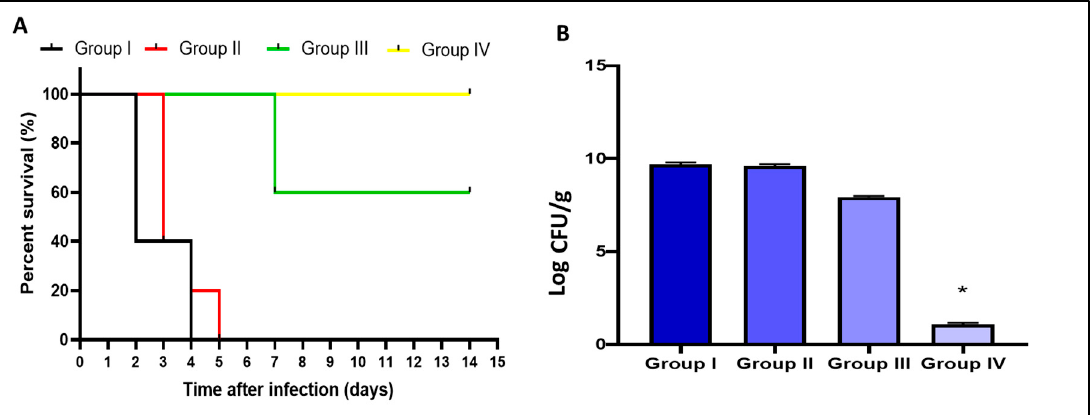
Figure 12. Survival curve ( A ) and the number of CFU/g lungs ( B ) of the different groups. The symbol (*) represents a significant difference ( p < 0.05) in comparison with the experimental groups I, II, and III. Lung tissues of the different experimental groups stained with H&E and Masson’s trichrome stain are shown in Figures 13 and 14,